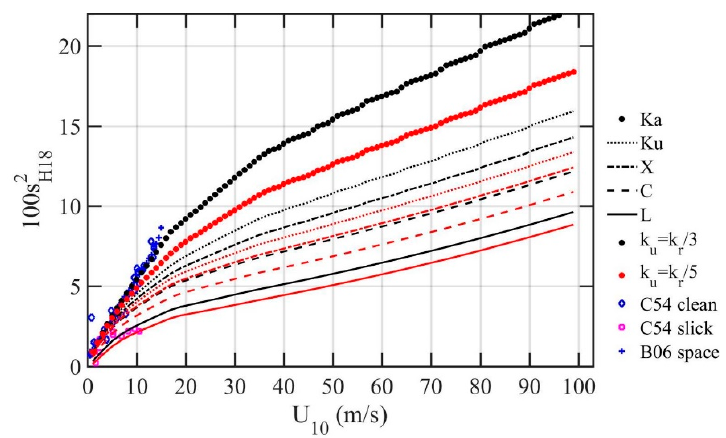
Figure 9. LPMSS for L (1.575 GHz, solid lines), C (6 GHz, dashed), X (10 GHz, dashed-dotted), Ku (13.575 GHz, dotted), and Ka (35.75 GHz, dots) bands based on the H18 spectrum (for normal incidence application), black curves are integration to k r /3 and red curves are integration to k r /5.